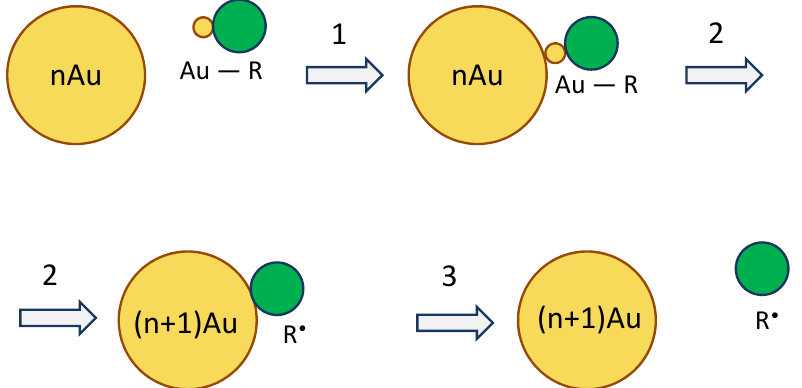
Figure 9. Auto-catalyitic mechanism of the nanoparticle growth. The Au(I) precursor compound diffuses to the gold nanoparticle, and the reduction of gold from Au(1) occurs directly at the surface, of the nanoparticle. The residue remains for some time at the surface, preventing the attachment of the next precursor molecule.